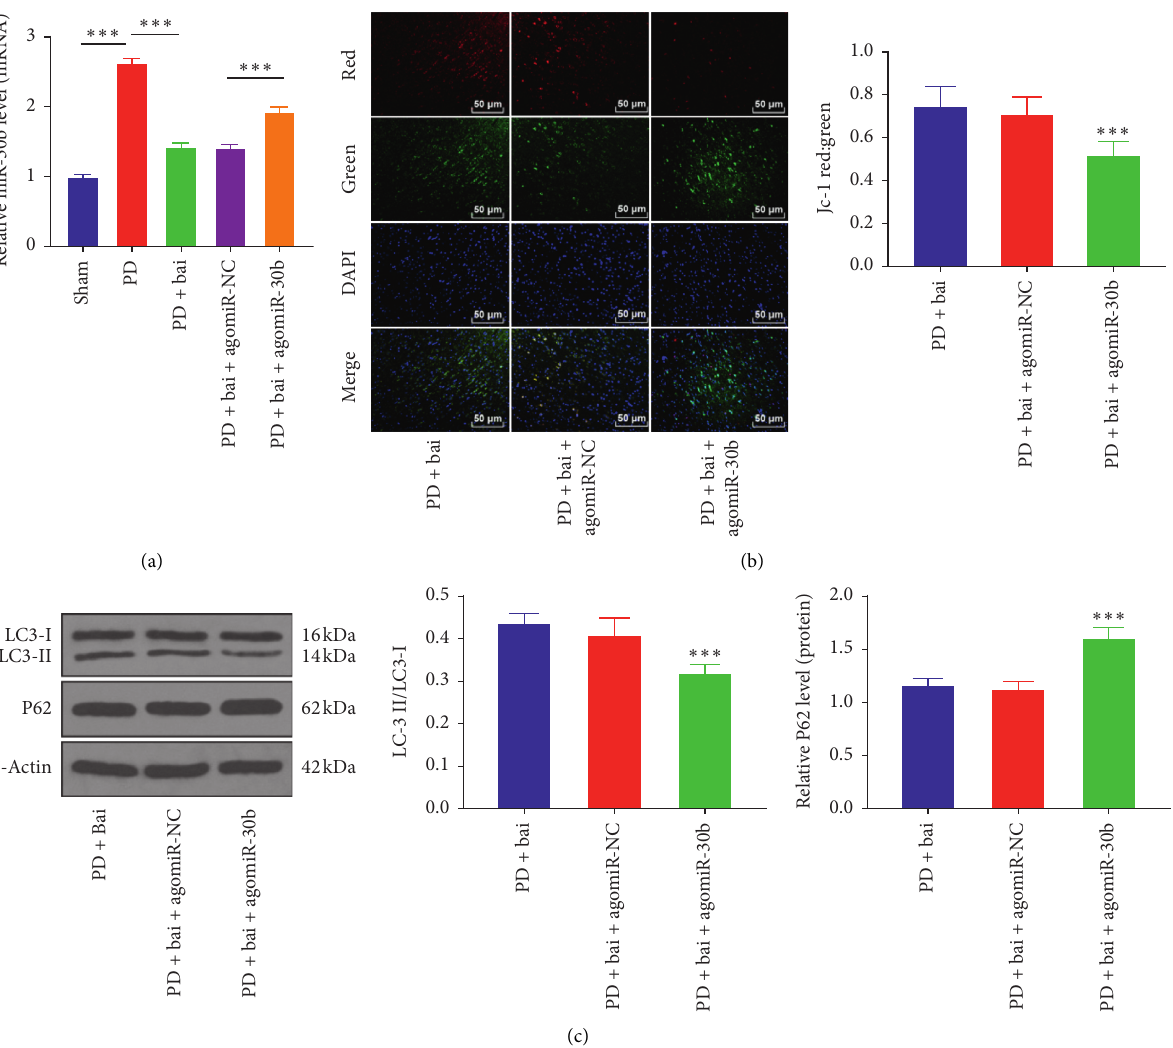
Figure 3: The upregulation of miR-30b reversed the promotive effect of baicalein on mitochondrial autophagy. The agomiR-30b was transfected into PD rats and the effect of overexpression of miR-30b on baicalein induced mitochondrial autophagy was observed. (a) The expression of miR-30b was detected by RT-qPCR. (b) Mitochondrial membrane potential was detected by JC-1 fluorescence staining. (c) The expressions of LC3 and P62 were detected by WB. N � 6. The data in the figure are all measurement data and the data are expressed as mean ± standard deviation; one-way ANOVA was used for variance analysis; Tukey’s multiple comparisons test was used for post hoc test. ∗∗∗ P < 0 . 001.